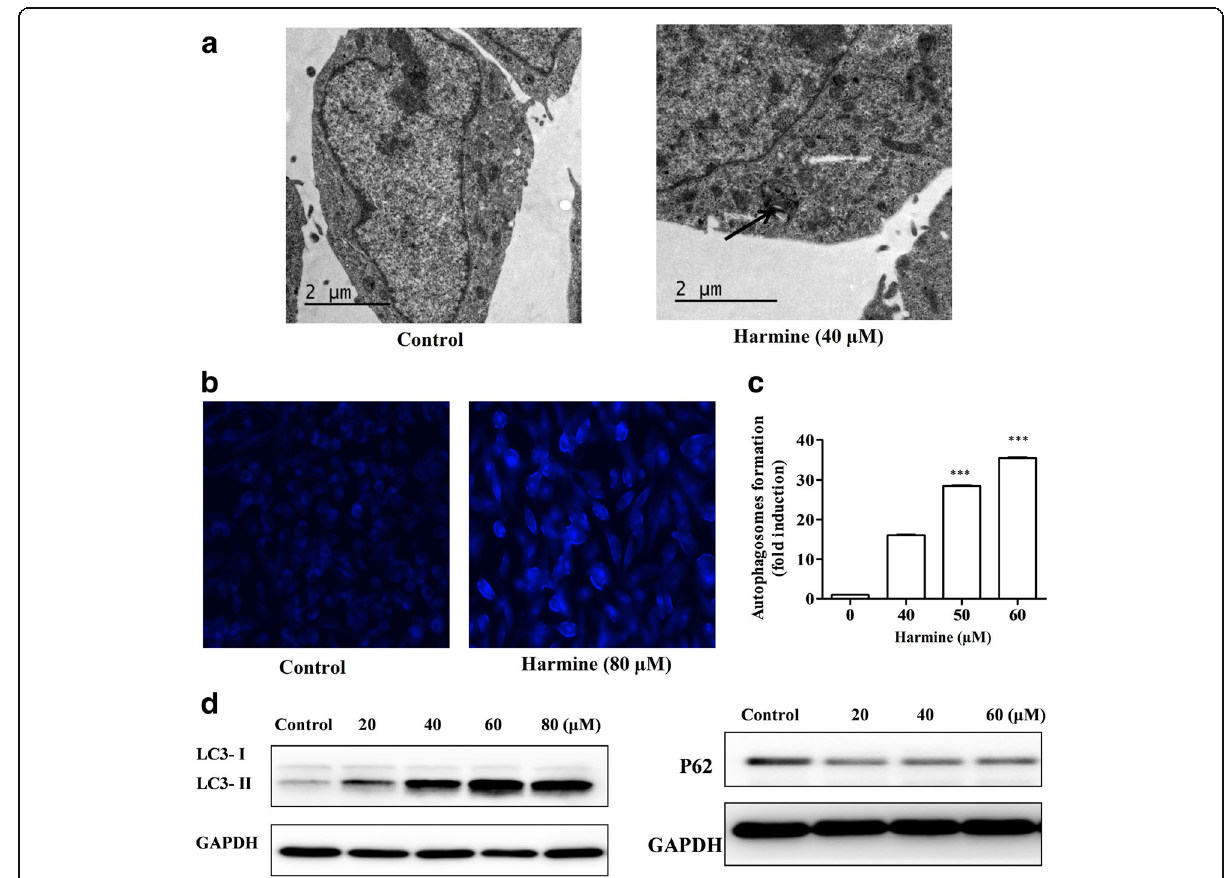
Fig. 3 Harmine induced autophagy in B16 cells. a: Electron micrographs of normal B16 cells (Control: magnification × 8200) and harmine-treated (40 μ M) B16 cells (magnification × 9900); b: Fluorescence microscope (magnification × 200) observation on accumulation of MDC-stained autophagic vacuoles of control and harmine-treated (80 μ M) B16 cells; c: The quantitative analysis of MDC-stained cells of harmine treated (40, 50 60 μ M) expressed as the mean±SD ( n =3). *** P <0.001 vs. the control group; and d: the autophagy induction evaluated by western blot analysis for LC3-II treated with harmine (20, 40, 60, 80 μ M) for 24 h and P62 proteins treated with harmine (20, 40, 60 μ M) for 2